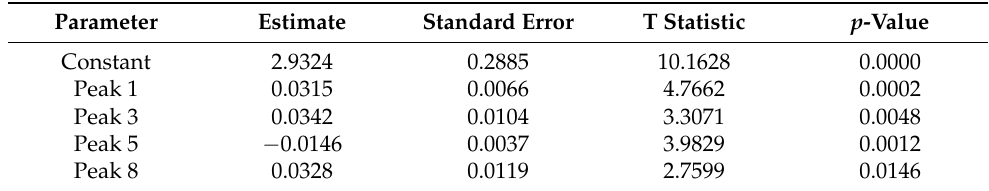
Table 3. Linear mathematical model, after stepwise backward elimination, to evaluate how the composition of the extract can explain the observed induction